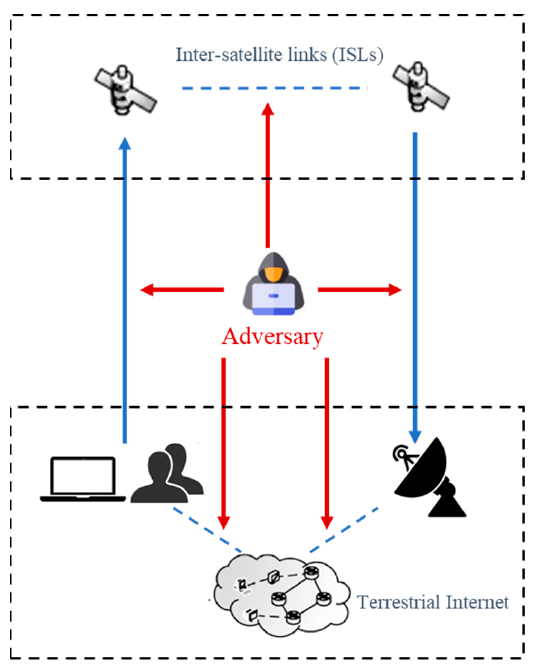
Figure 2. DDoS attacks on LSCNs.